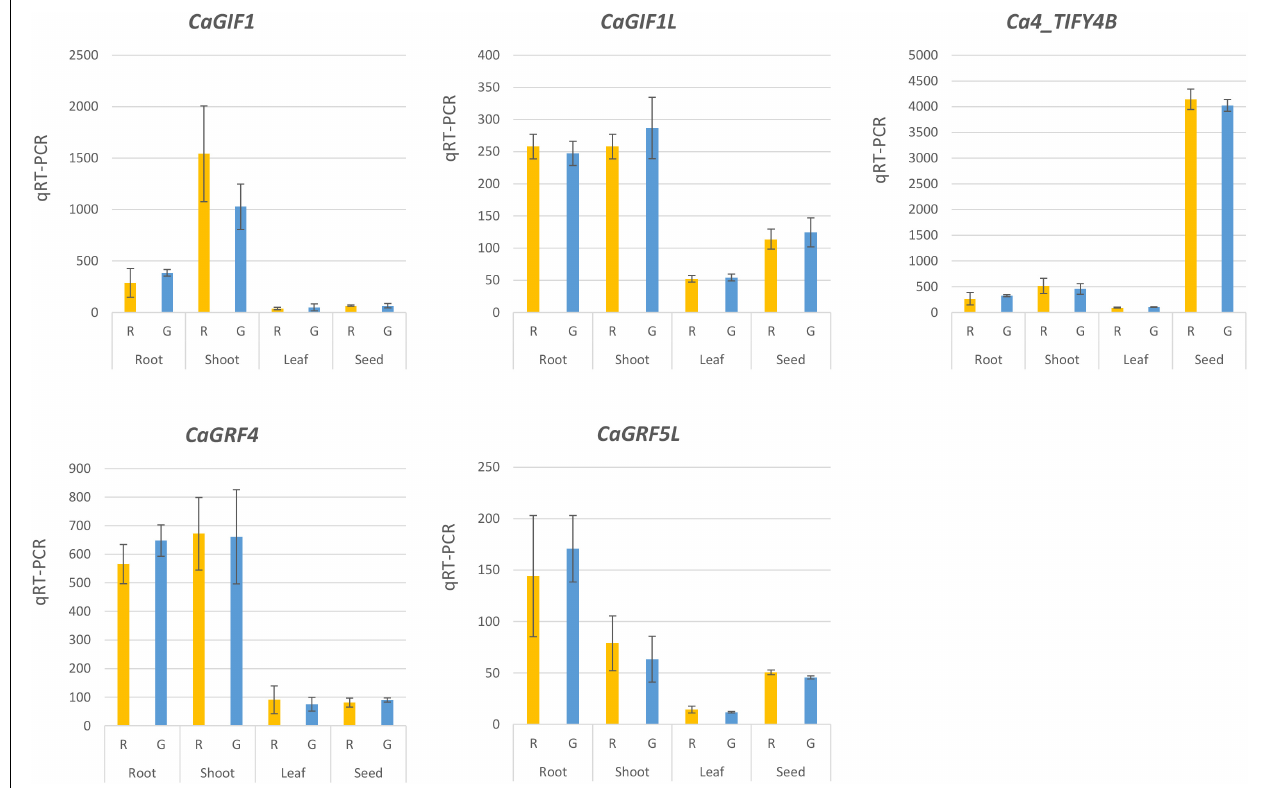
FIGURE 6 | Absolute quantitative real-time PCR (qRT-PCR) analysis of expression of chickpea GIF1 , GIF1L , GRF4 , GRF5L , and Ca4_TIFY4B in NILs carrying contrasting Ca4_TIFY4B alleles, Rupali (R) or Genesis836 (G). NILs were derived from RIL50, heterozygous across the vigor region Ca4_Vqtl . Gene expression was analyzed for whole shoot and root harvested at 9 days after sowing, youngest fully emerged leaves sampled at 7 weeks after sowing, and developing seed. Means ± SD are shown for n = 3 or 4. There were no significant differences in expression for any of the tested genes in these tissues ( P >